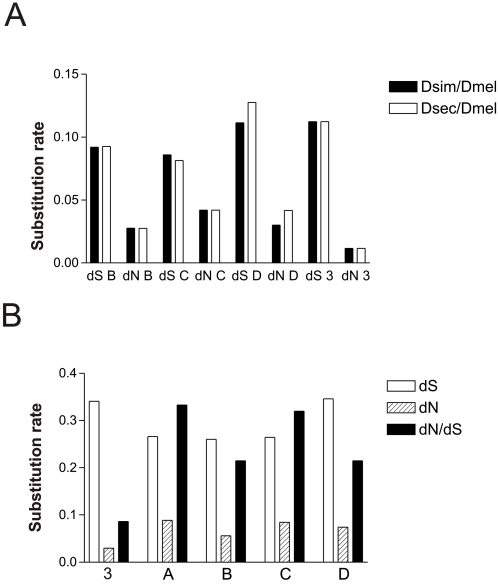
Comparisons of substitution rates and ω.A. Pairwise comparison of the dS and dN rates of exons B, C, D and three conservative small exons (symbol 3 on the figure) in D. simulans vs. D. melanogaster and D. sechellia vs. D. melanogaster. B. Results of pairwise comparison of the dS, dN rates and of the ω ratio of the exons A, B, C, D and three conservative small exons (symbol 3 on the figure) in the pair of species: D. melanogaster vs. D. yakuba.